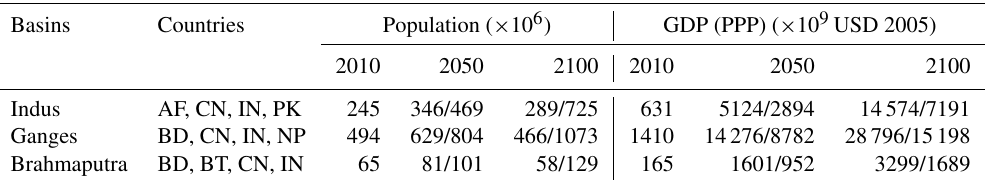
Table 1. Projected basin-aggregated population counts and GDP (PPP = purchasing power parity) for SSP1 and SSP3. The population counts are extracted from the HYDE v3.2 database (Klein Goldewijk et al., 2010). The GDP (PPP) is a product of the population counts and the country-specific GDP (PPP) per capita, which is derived from the IIASA SSP database (IIASA, 2017) as the ensemble mean of the IIASA GDP and OECD Environmental Growth